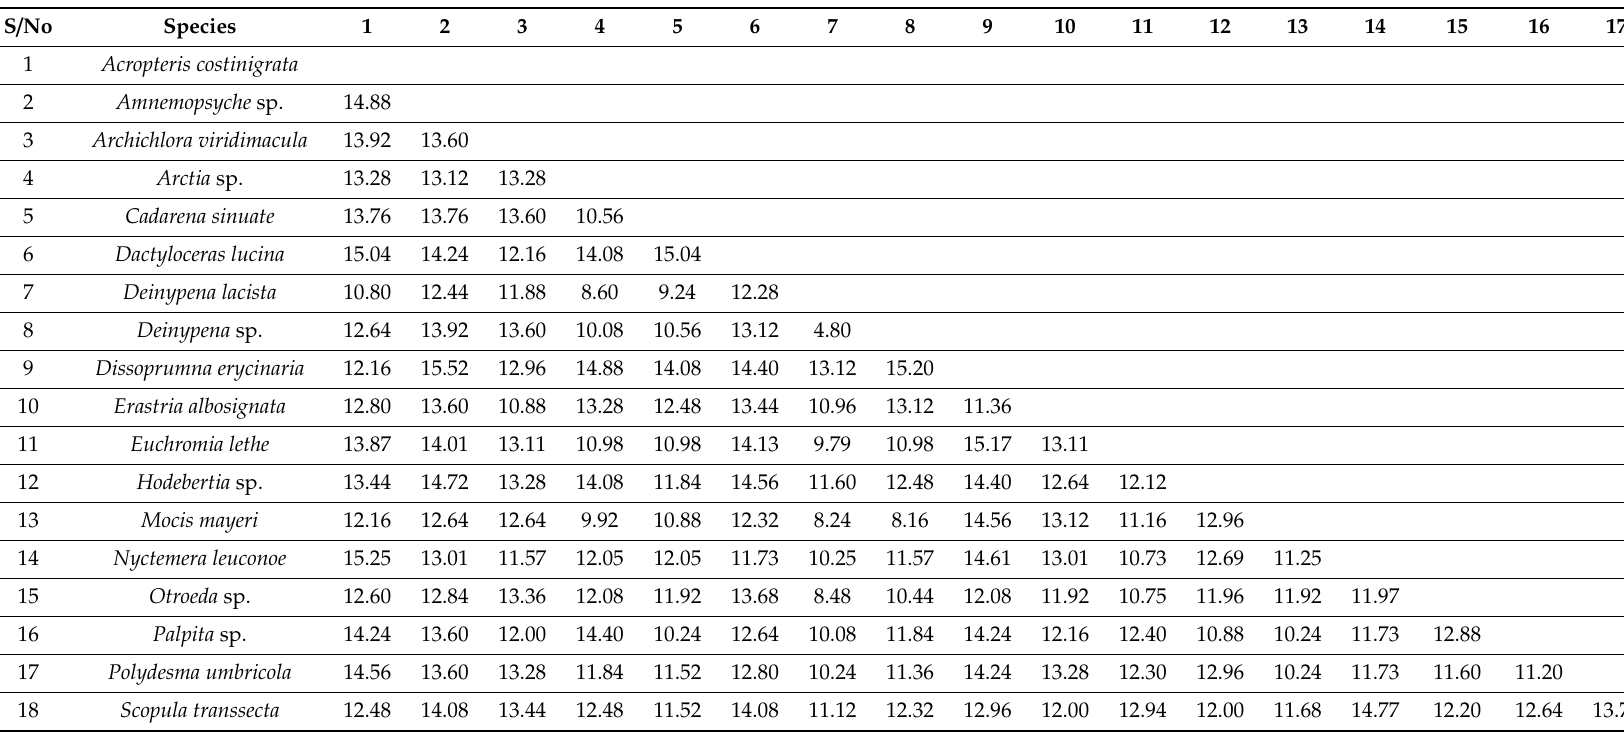
Table 2. Estimates of Evolutionary COI Divergence over Sequence Pairs (%) between species of moths from Nigeria using Kimura-2